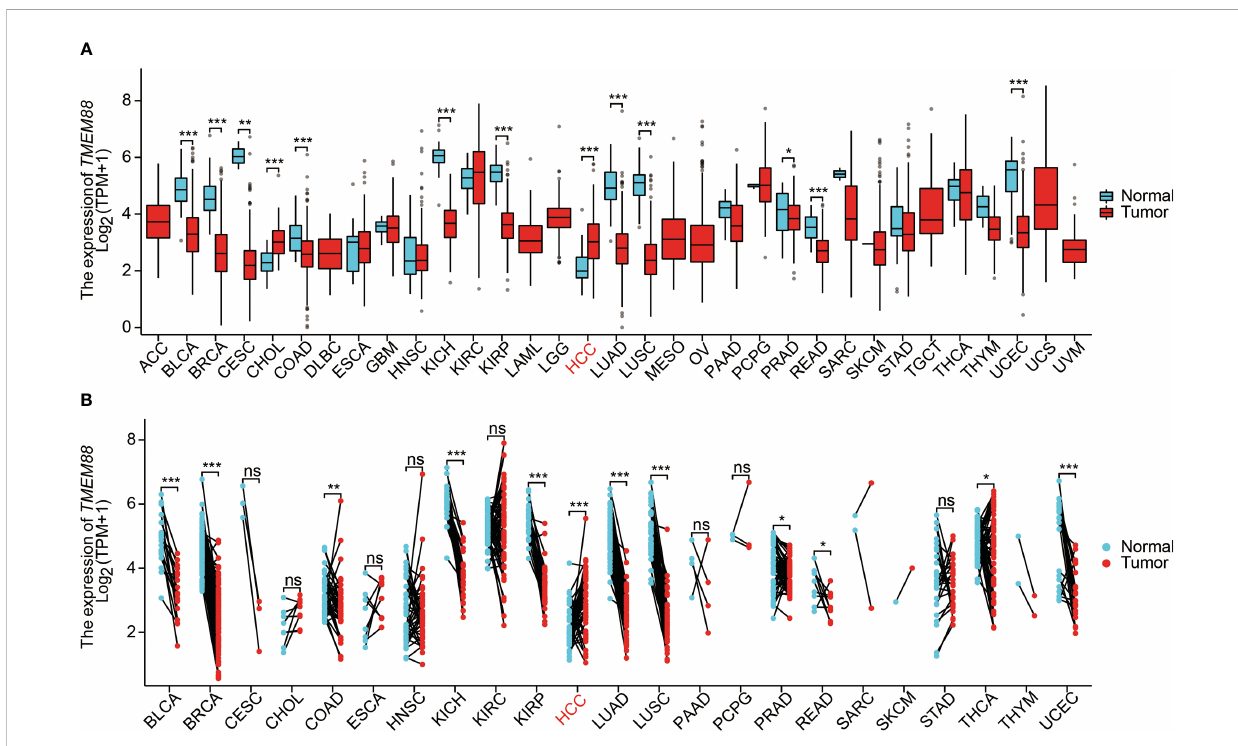
FIGURE 1 TMEM88 mRNA expression in different cancers. (A) Boxplot indicates the mRNA level of TMEM88 in normal tissues and tumor samples derived from different tumor types. Data was analyzed by Wilcoxon signed rank test. (B) The mRNA level of TMEM88 in speci fi c tumor samples and their adjacent matched nontumorous tissues were compared. Each dot represents a sample specimen. Data was analyzed by Wilcoxon rank sum test. *P<0.05, **P<0.01,***P<0.001, ns, not signi fi